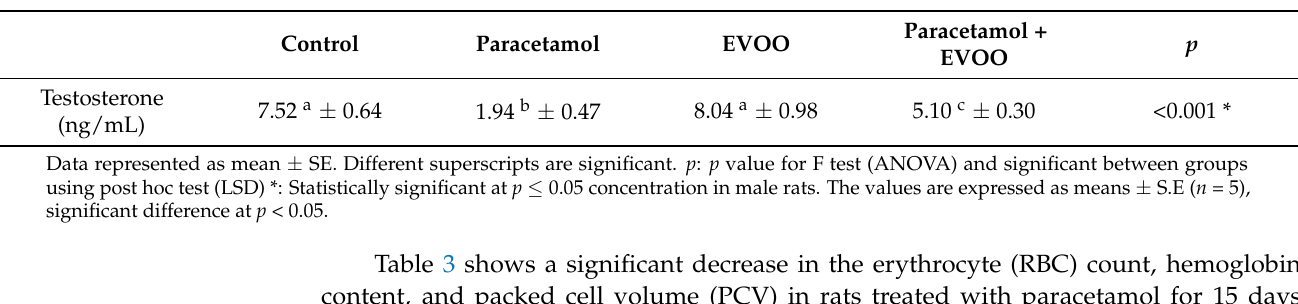
Table 2. Effect of administration of paracetamol and/or EVOO on testosterone concentration in male Wistar rats.